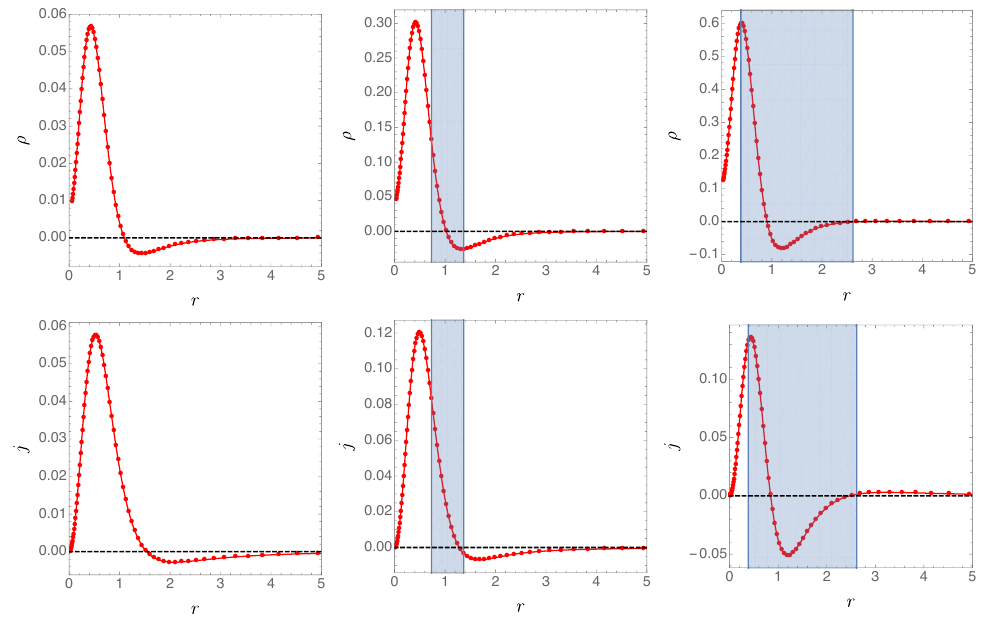
Figure 6 . The holographic energy density (top row) and holographic angular momentum density (bottom row) computed with n = 2. The dashed horizontal line marks 0, and the blue region indicates the location of the boundary ergoregion. From left to right, in each of the rows, we have a = 0 : 9 ; 2 : 1 ; 3. (The last value corresponds to a max .)